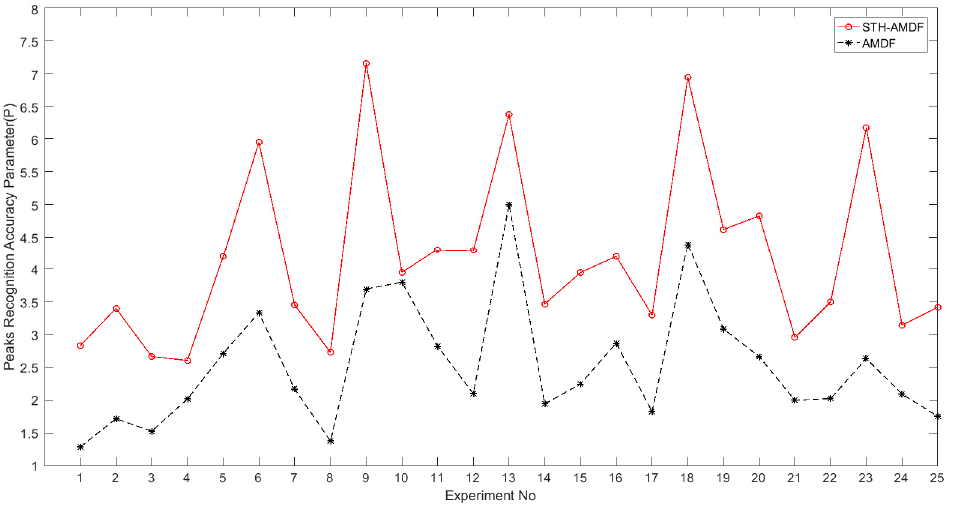
Figure 9. The peaks recognition accuracy parameter distribution using the AMDF and STH-AMDF methods.